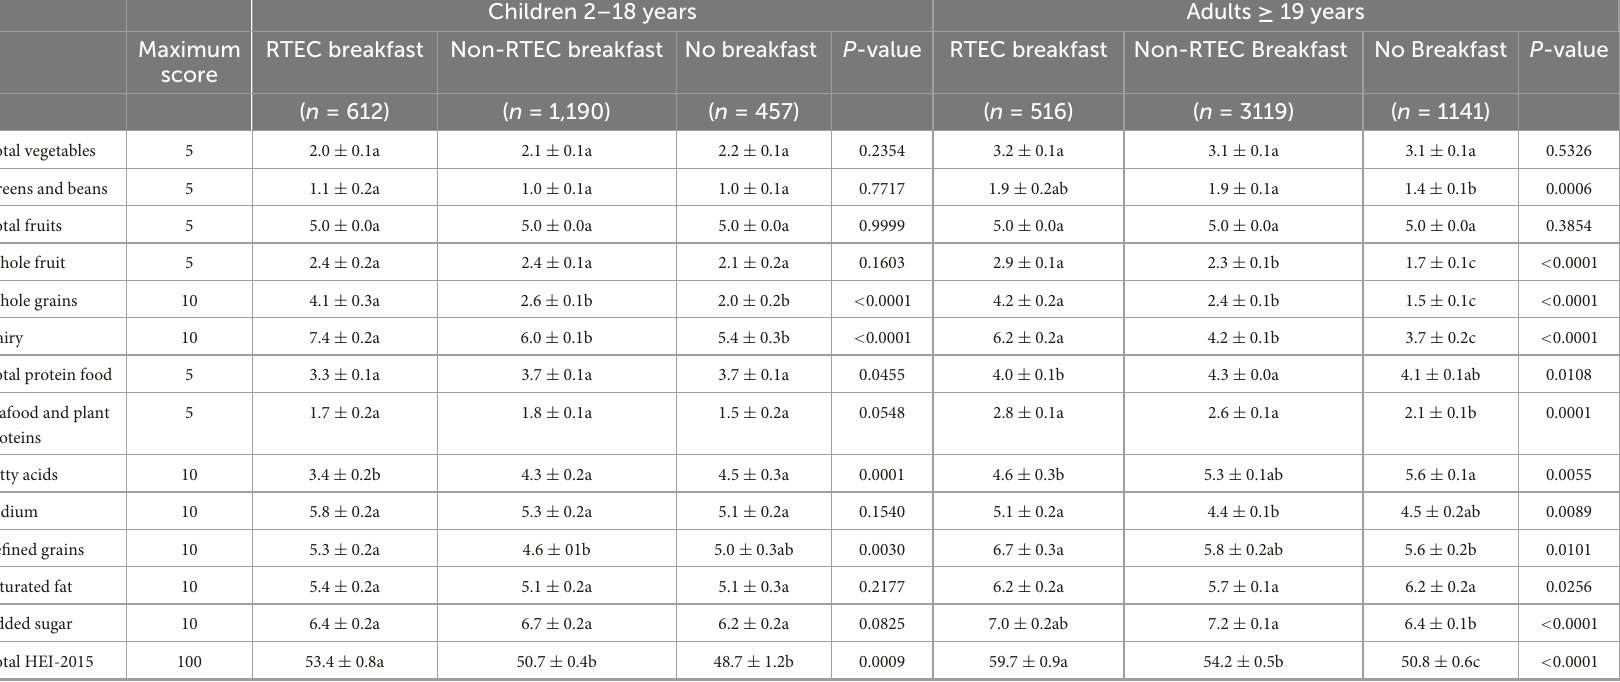
TABLE 4 Healthy Eating Index (HEI)-2015 total score and sub-scores in US children and adults by breakfast status, National Health and Nutrition Examination Survey, 2017 –